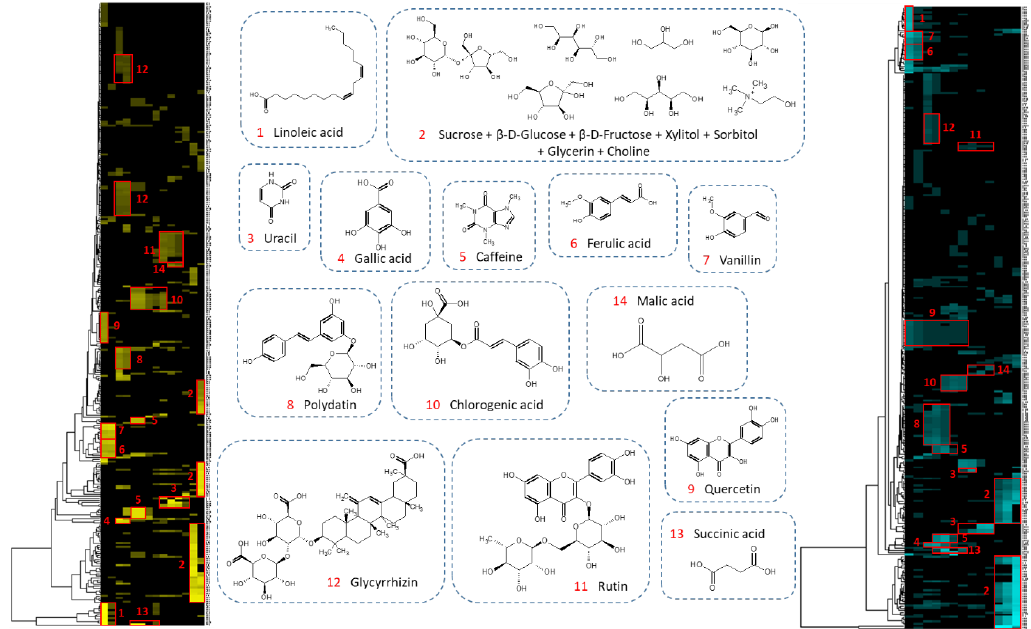
Figure 6. 13 C-NMR chemical shift clusters obtained by applying HCA on dry model extract (left) and diluted in glycerin (right).